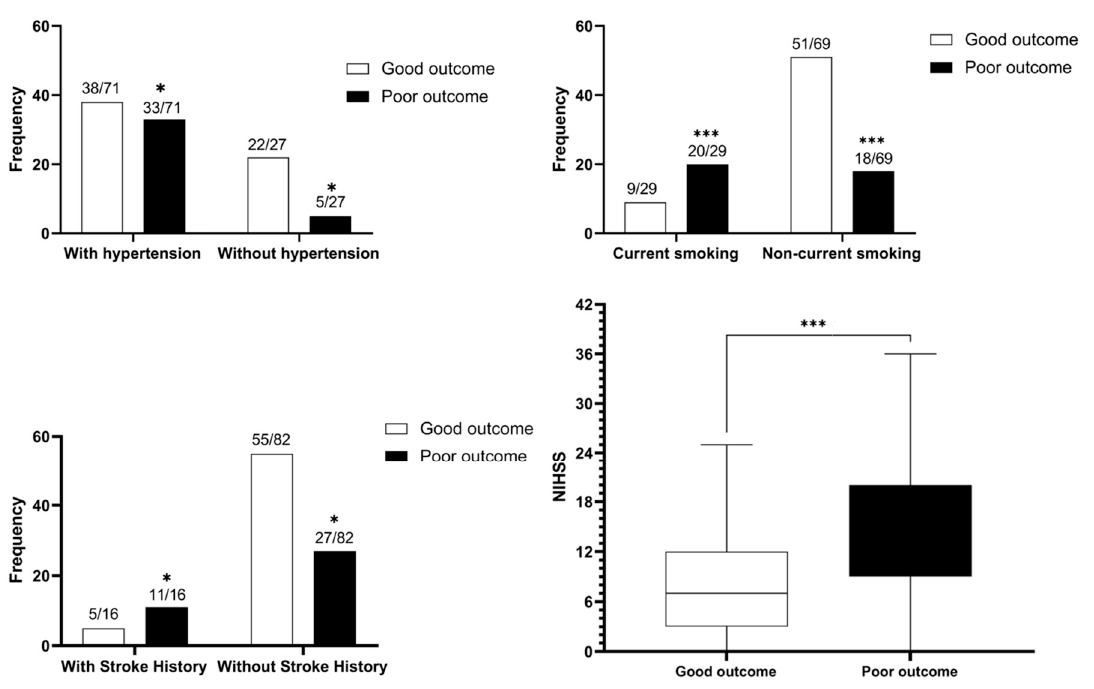
Figure 3. The column charts and boxplot results of significant factors related to a poor outcome in small (<70ml) FIV; Good outcome (mRS 0-2) and poor outcome (mRS 3-6). *: p <0.05; ***: p <0.001. Table 4. The discrepancies between different functional outcomes in FIV < 70 mL.